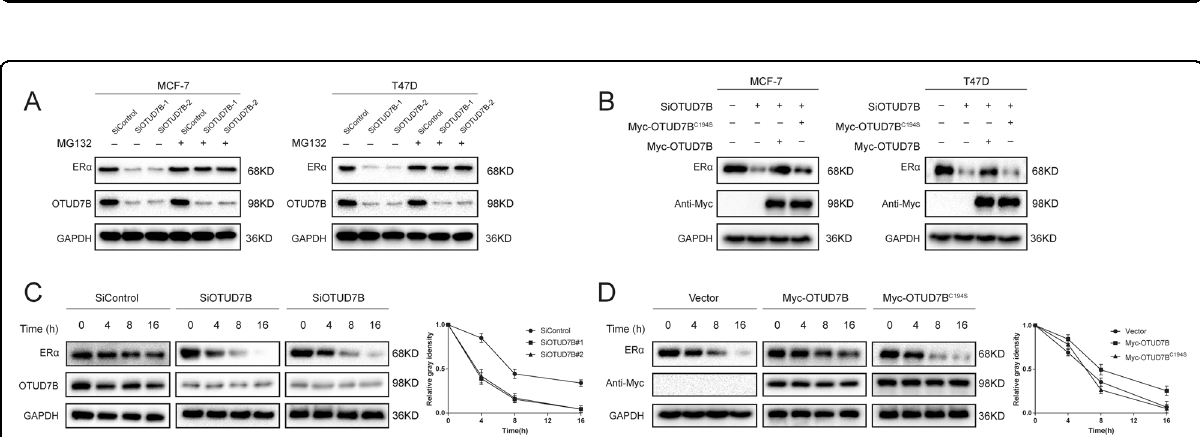
Fig. 5 OTUD7B increases ER α stability. A In the presence of the proteasome inhibitor MG132, depletion of OTUD7B did not further decrease the ER α protein level. Breast cancer cells were transfected with siOTUD7B or siControl. After 48 h, cells were treated with 10 µM MG132/vehicle for 6 h; cell lysates were prepared for western blot analysis. B MCF-7 cells were transfected with OTUD7B (wild type or C194S) together with OTUD7B siRNA. The ER α levels were measured. C OTUD7B depletion decreased ER α half-life in breast cancer cells. Breast cancer cells were transfected with siOTUD7B or siControl. After 48 h, cells were treated with 100 µM cycloheximide/vehicle for indicated times. Cell lysates were prepared for western blot analysis. D OTUD7B C194S did not increase ER α half-life in HEK293 cells. HEK293 cells were transfected with HA-ER α plasmid and Myc-tag, Myc-OTUD7B, or Myc- OTUD7B C194S plasmids. After 24 h, cells were treated with 100-µM cycloheximide/vehicle for indicated times. Cell lysates were prepared for Western blot